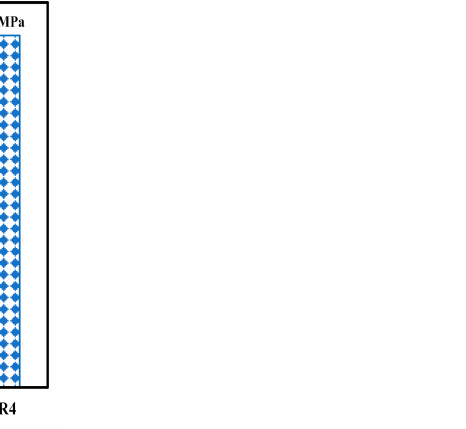
Figure 8. Effect of MWCNTs and F-MWCNTs on the mechanical properties of Kevlar-reinforced epoxy.